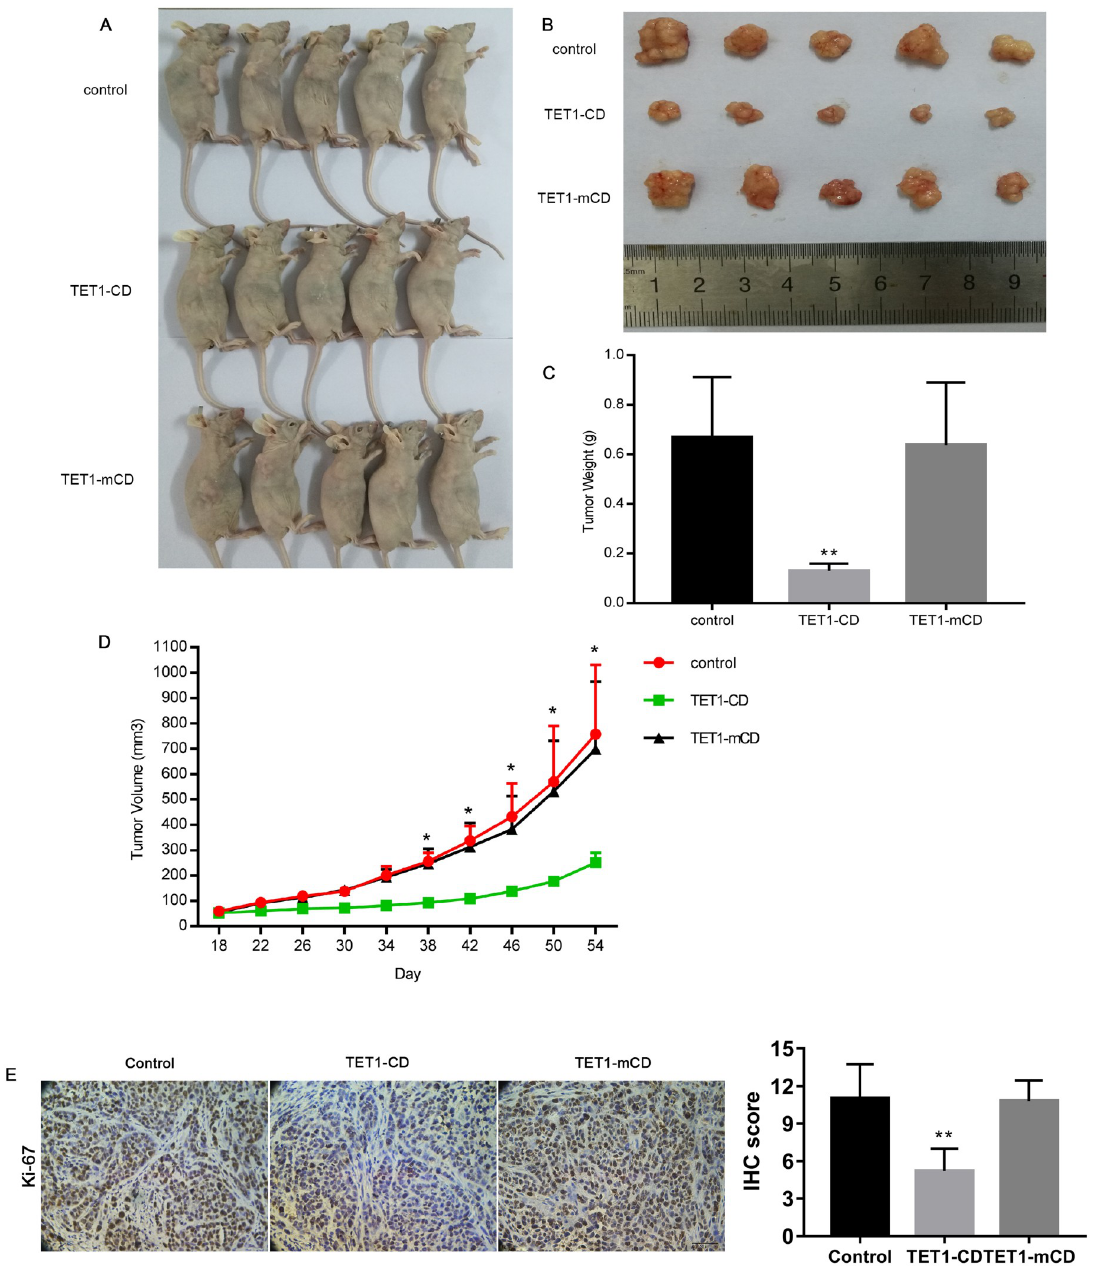
Fig 4. TET1-CD suppresses HCC xenografts growth in nude mice. (A). The SMMC 7721 cells, which were transiently transfected with empty vector, TET1-CD plasmids or TET1-mCD plasmids, were subcutaneously injected into the nude mice to establish a HCC subcutaneous xenograft model. The nude mice were sacrificed 54 days after the injection. (B). Photographs of excised xenograft tumors. (C). Tumor weight in the control, TET1-CD and TET1-mCD groups are shown. (D). From day 18 and 54 after the injection, the relative tumor volume was measured once every four days. The results were represented as mean ± SD (n = 5). (E). Ki-67 positive tumor cells were detected by immunohistochemistry (IHC). The results were represented as mean ± SD (n = 10). The scale bar is 50 μ m. One-way ANOVA, �� p <